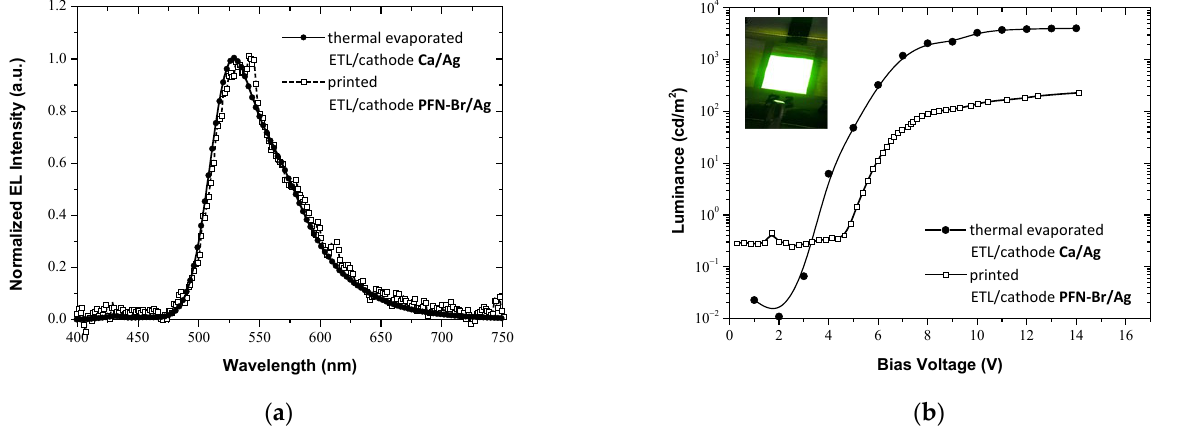
Figure 6. ( a ) The normalized intensities of EL emissions measured from fully printed and reference F8:F8BT OLEDs. ( b ) Luminance-voltage (L-V) plots of the fabricated fully printed and reference F8:F8BT OLEDs.